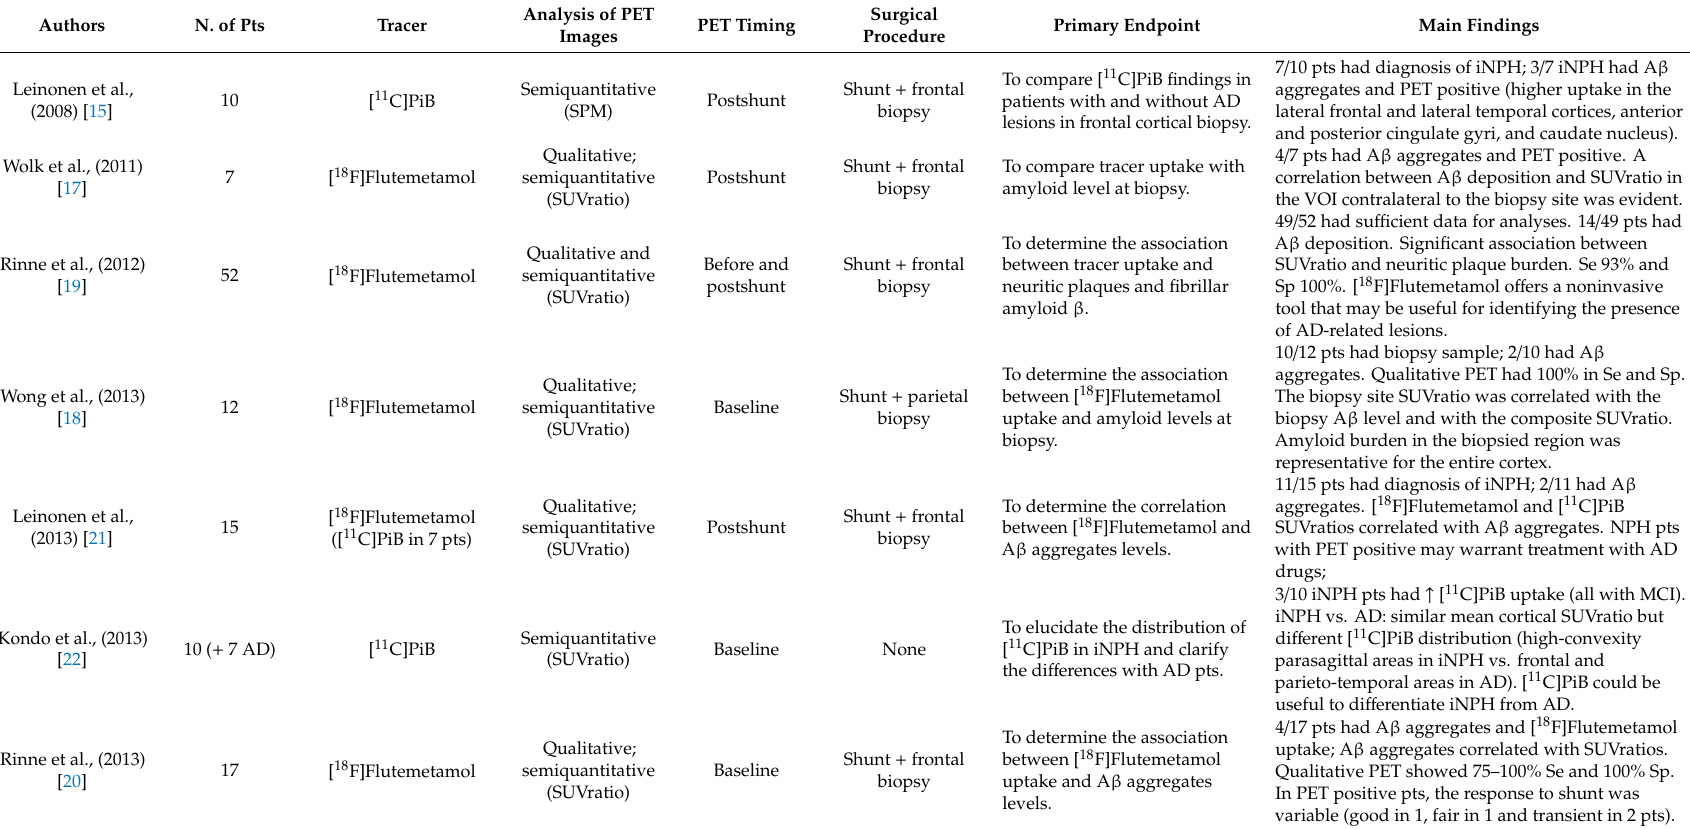
Table 1. Amyloid PET imaging in NPH